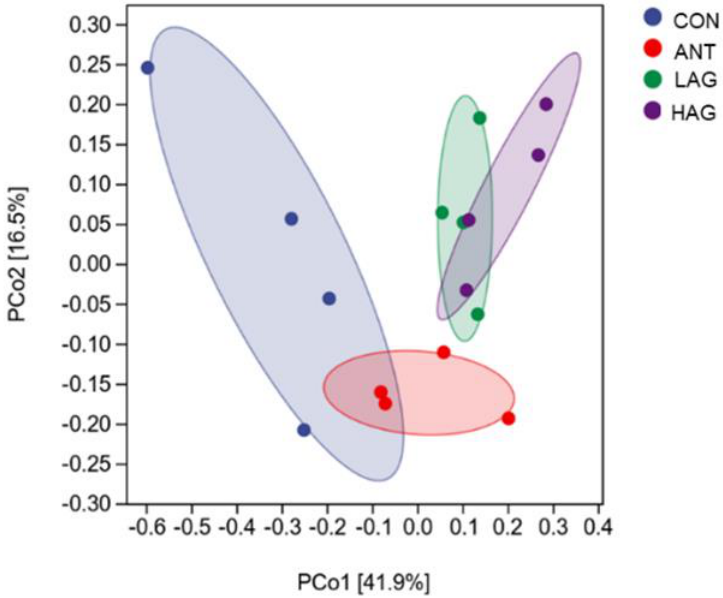
Figure 3. The cecal microbiota’s principal coordinate analysis (PCoA) was based on the Weighted UniFrac distance (n = 4).